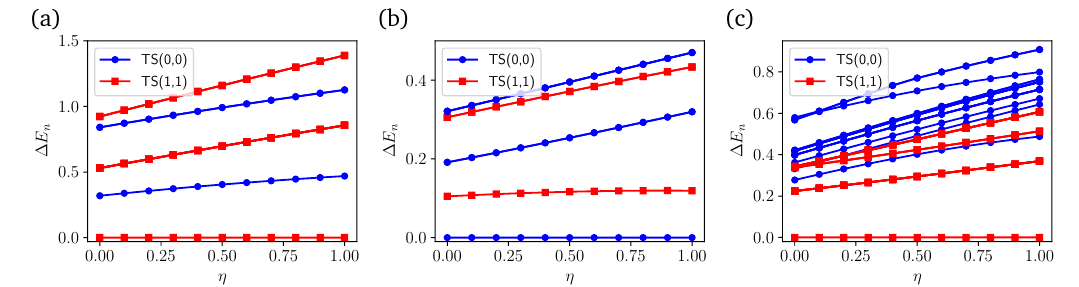
Figure 5: Low energy excitation spectrum of the interpolated Hamiltonian ( 1 − η ) H + η H for systems with N = 12,16,36 sites in (a,b,c) respectively. Energy 0 2 states in the topological sector TS ( 0,0 ) are plotted in blue (circles), and the ones in TS ( 1,1 ) are plotted in red